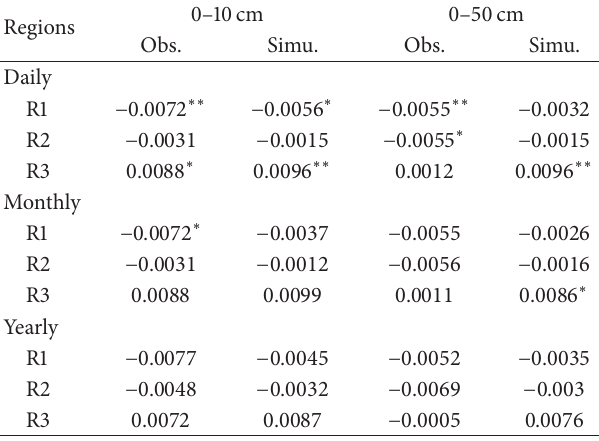
Table 3: The linear trends of simulated and measured SM over the subregions (unit: (m 3 /m 3 )/10a).